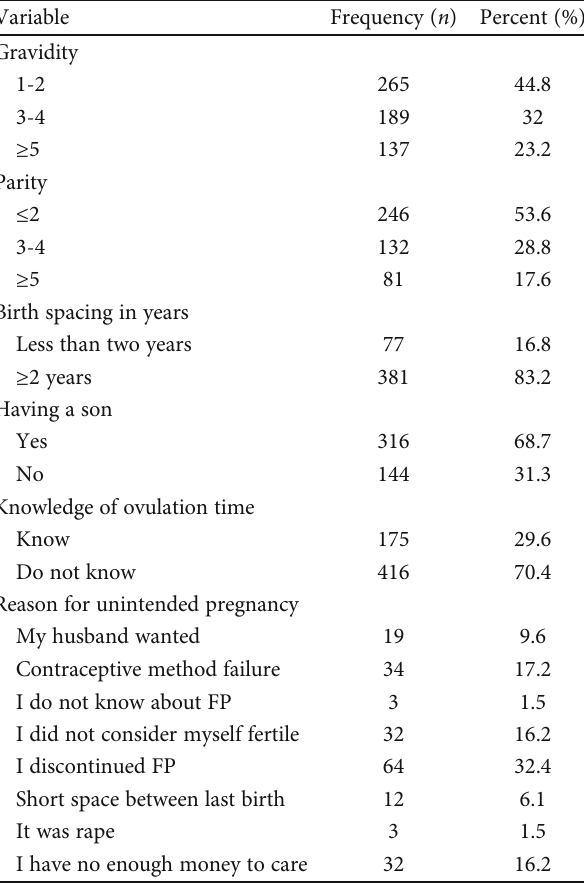
Table 2: Pregnancy- and health-related characteristics of pregnant women attending ANC in a public health facility in Bako Tibe district, Oromia, Ethiopia, 2019 ( n = 591